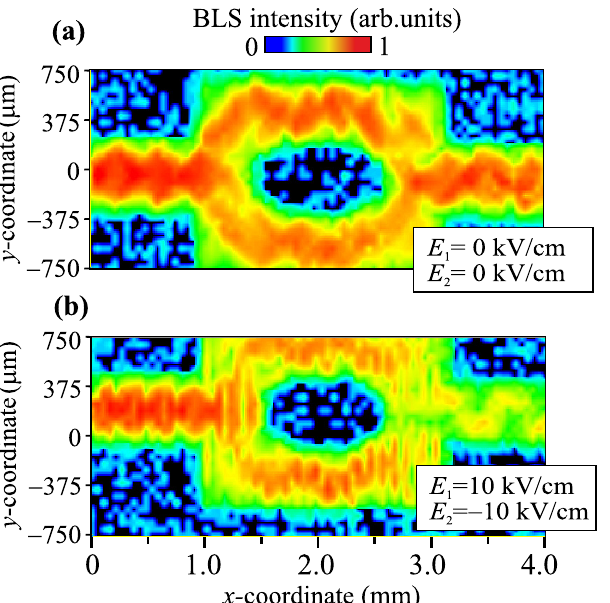
Figure 4. 2D spatial maps of BLS intensity I BLS in the case of E 1,2 = 0 kV/cm ( a ) and E 1,2 = ± 10 kV/cm ( b )